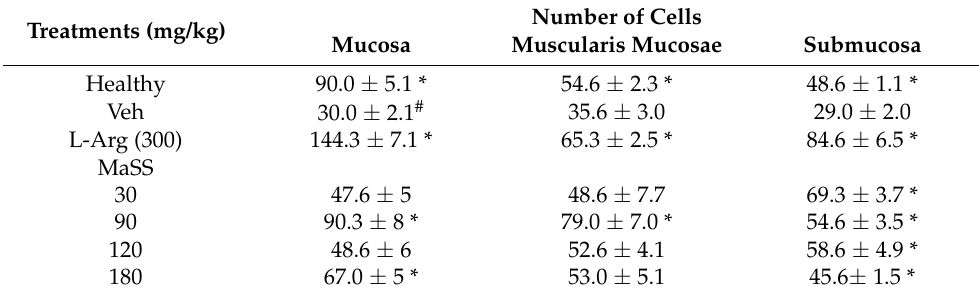
Table 1. Cell count of each of the stomach strata. Number of Cells Treatments (mg/kg) Mucosa Muscularis Mucosae Submucosa Healthy 90.0 ± 5.1 * 54.6 ± 2.3